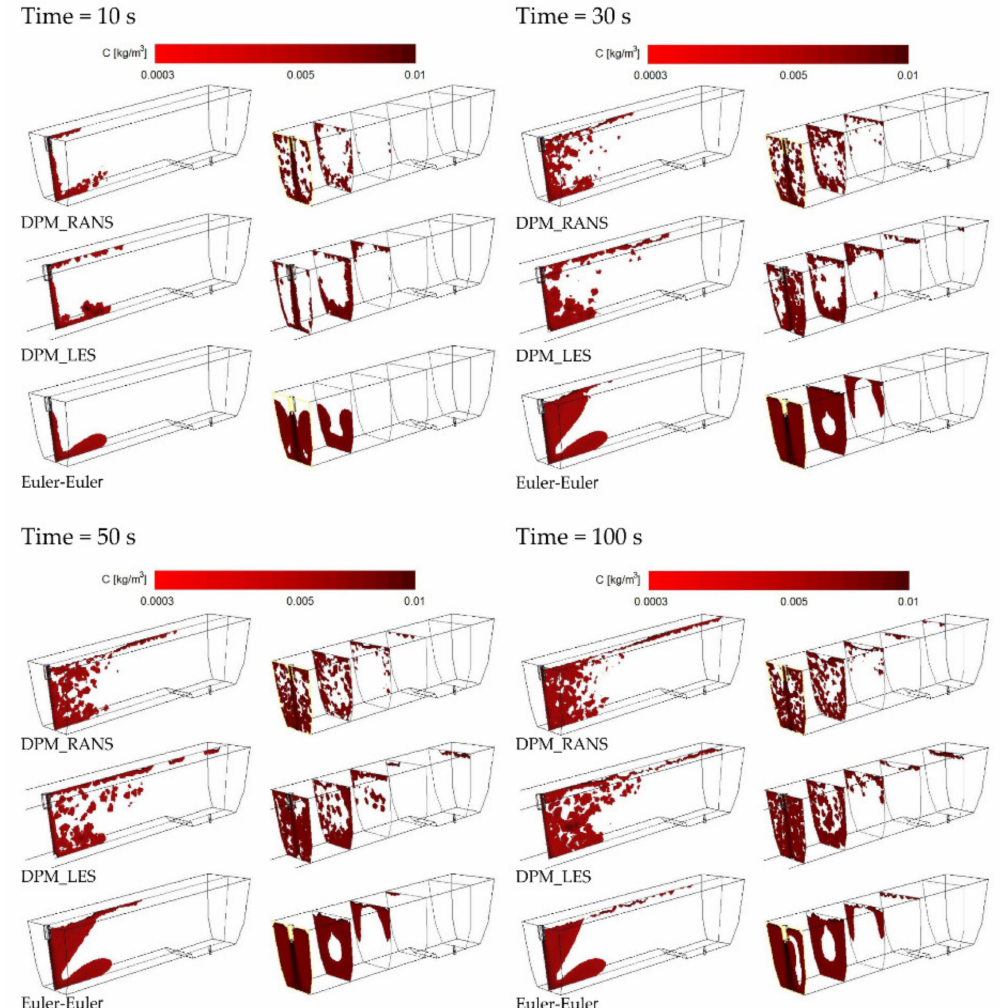
Figure 7. Contour maps of microparticles distribution (140 µ m) on the control